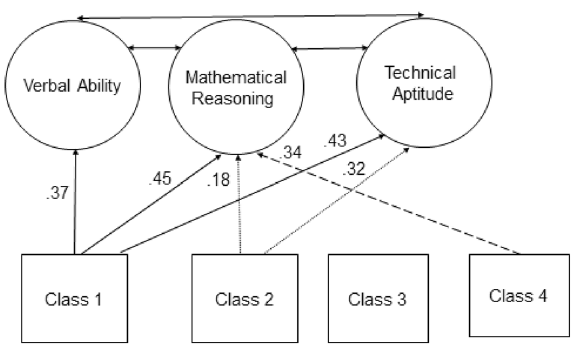
Fig. 4 Correlations of SLAT scores with external test scores by